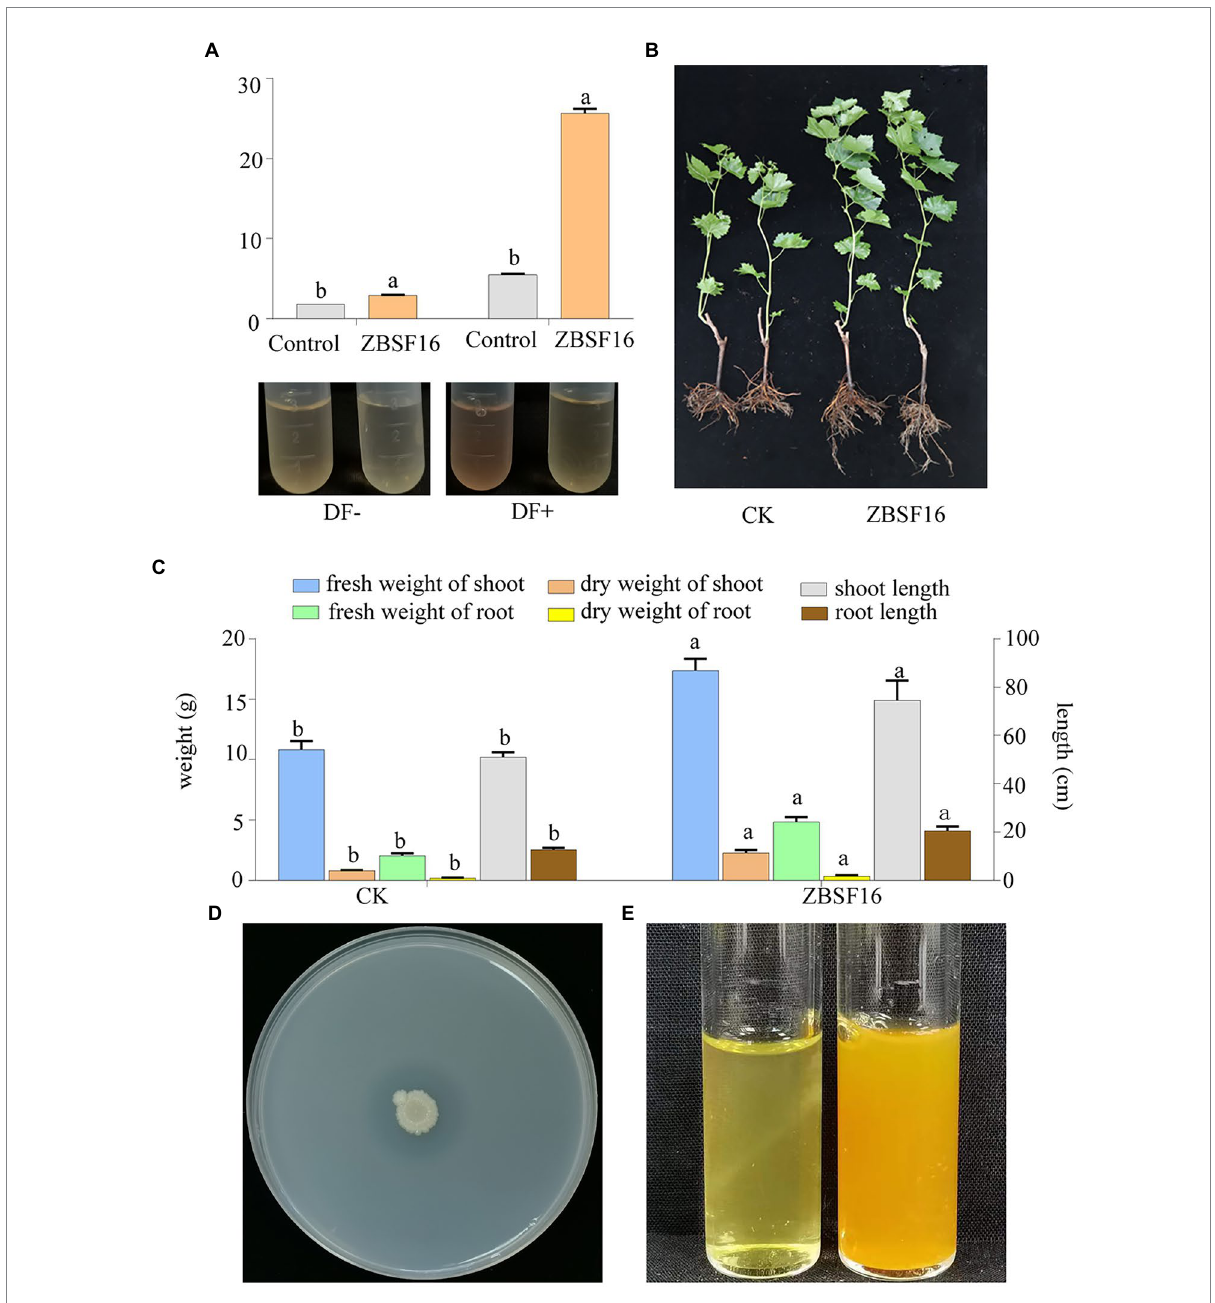
FIGURE 2 Determination of the plant growth-promoting properties of Paenibacillus peoriae ZBSF16. (A) IAA production of P. peoriae ZBSF16. DF − , DF medium without L-tryptophan; DF+, DF medium containing L-tryptophan. (B,C) The growth-promoting effect of Paenibacillus peoriae ZBSF16 on grape; (D) mineral phosphate solubilization of P. peoriae ZBSF16; (E) ammonia production of P. peoriae